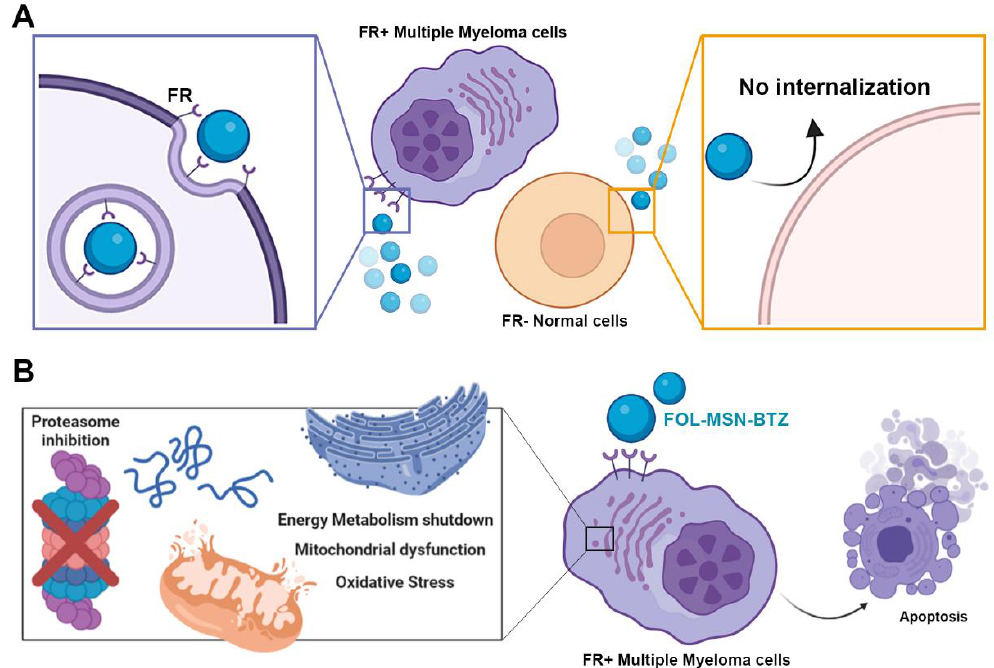
Figure 7. FOL-MSN-BTZ selectively alters metabolism and induce death in FR + MM cells. ( A ) FOL-MSN-BTZ is selectively internalized by FR + MM cells, but not by FR − normal cells. ( B ) Once inside the target cell, FOL-MSN-BTZ inhibits the proteasome machinery, which, in turn, leads to metabolic dysfunction and oxidative stress, eventually triggering apoptosis.